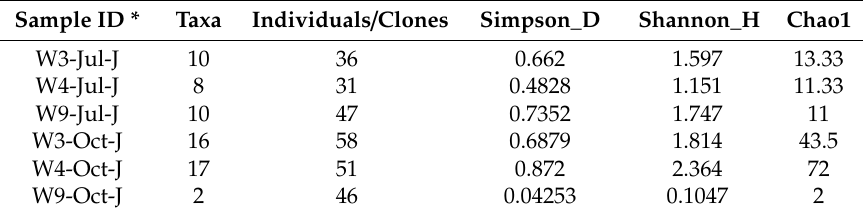
Table 2. Diversity indices of prey organisms in the F. enflata juveniles samples analyzed. Sample ID * Taxa Individuals /